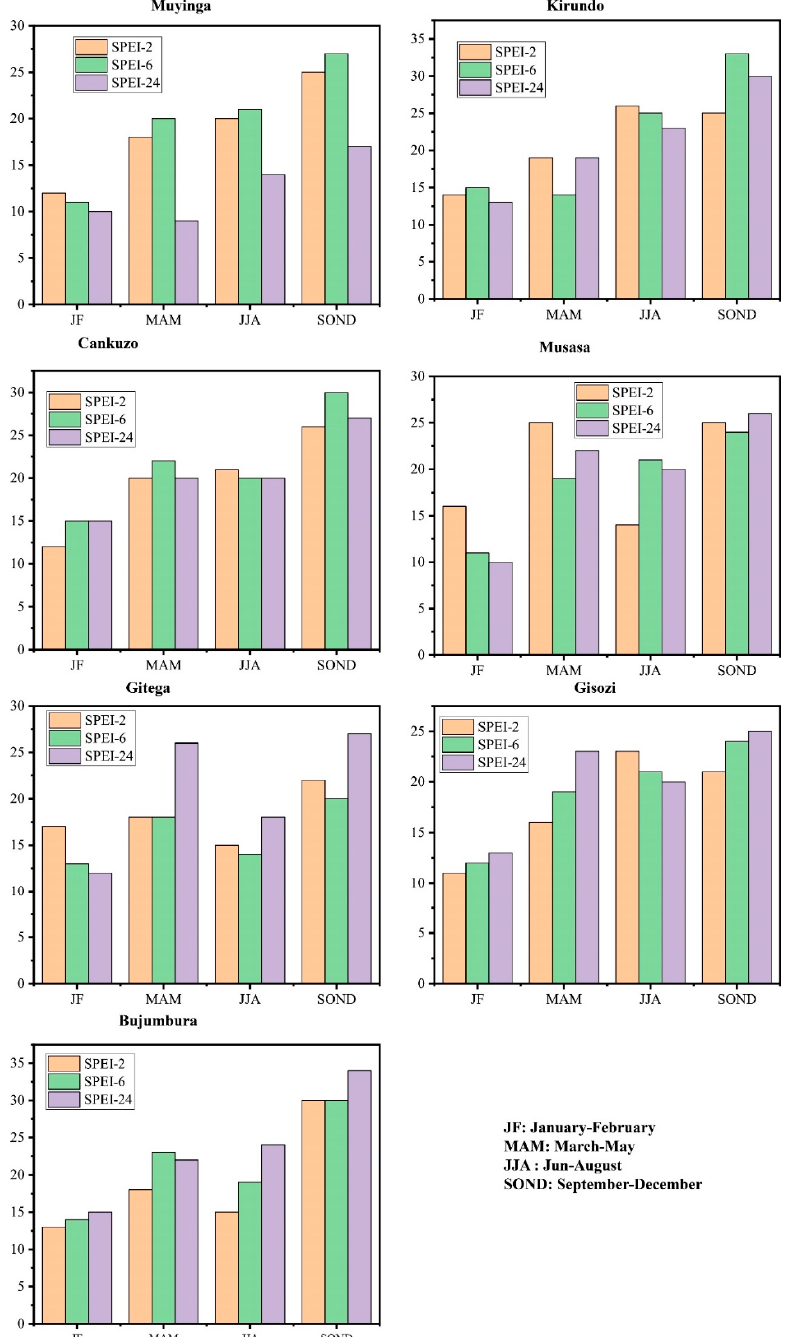
Figure 7. The quantified historical drought events in the JF, MAM, JJA, and SOND seasons for Muyinga, Kirundo, Cankuzo, Musasa, Gitega, Gisozi, and Bujumbura stations.